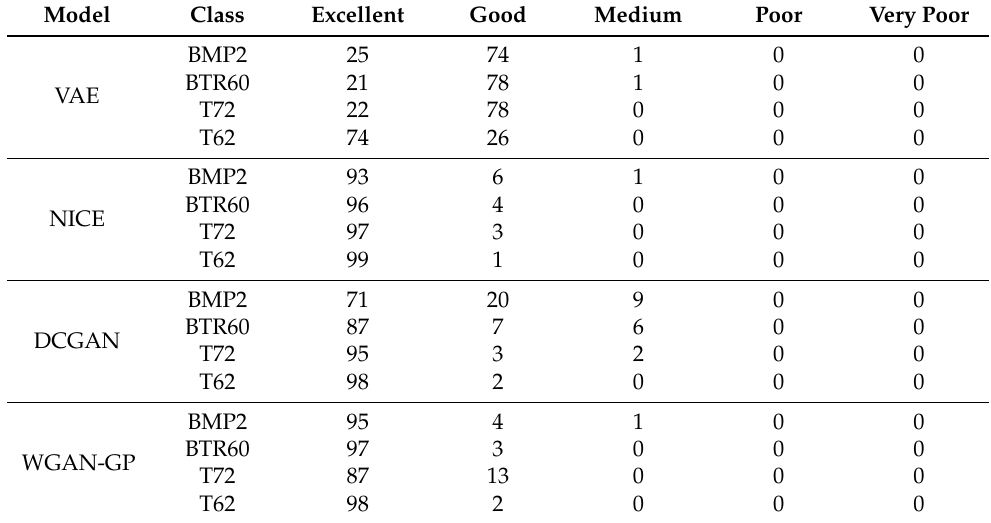
Table 4. Statistics of valuetion